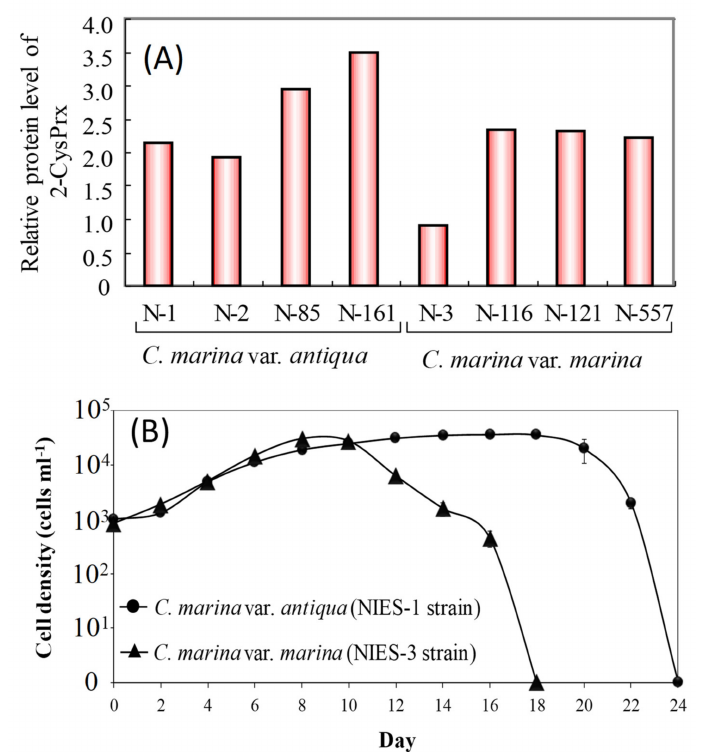
Figure 6. Difference of 2-CysPrx protein expression levels in Chattonella marina strains ( A ) and cell density versus culture duration in NIES-1 (2-CysPrx-normal-expression strain) and NIES-3 strains (2-CysPrx-low-expression strain) ( B